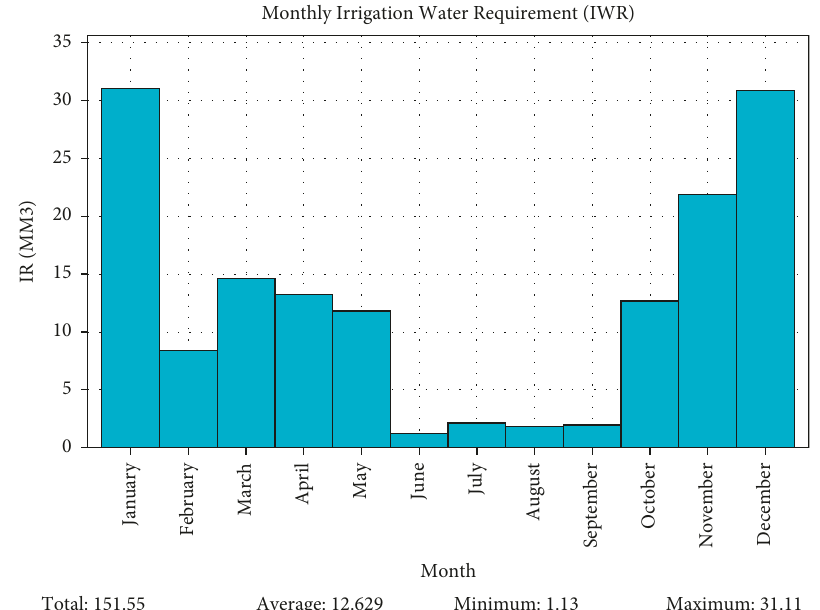
Figure 6: Current monthly irrigation water demand distribution.